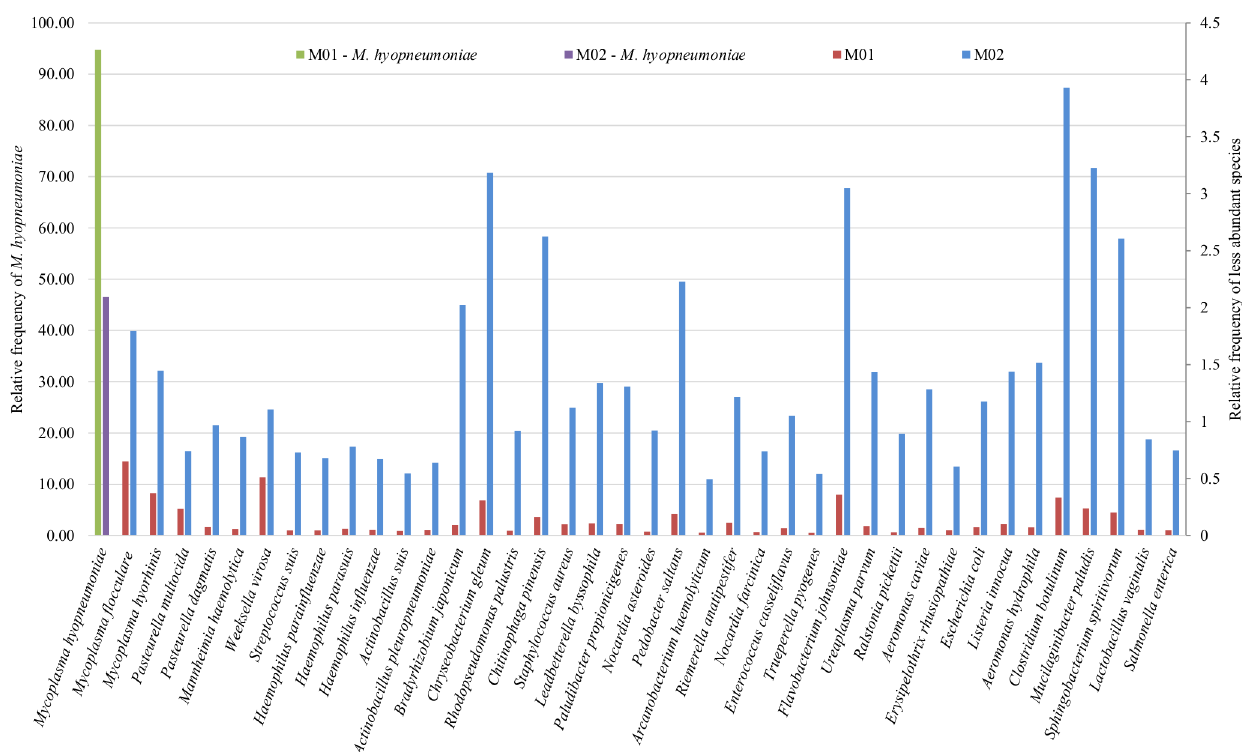
Fig 5. Mapped reads to the most abundant species identified. Normalizeddata points are separatedinto two y-axes, mainly one for the M . hyopneumoniae species and the other one for the rest of the species. In the x-axis, the most abundantspecies are shown. The y-axis shows the relativefrequencyin two scales; left: in green (M01) and purple(M02) the relativefrequency scales for M . hyopneumoniae ; right in red (M01) and blue (M02), the relative frequency scale for the remainingspecies.